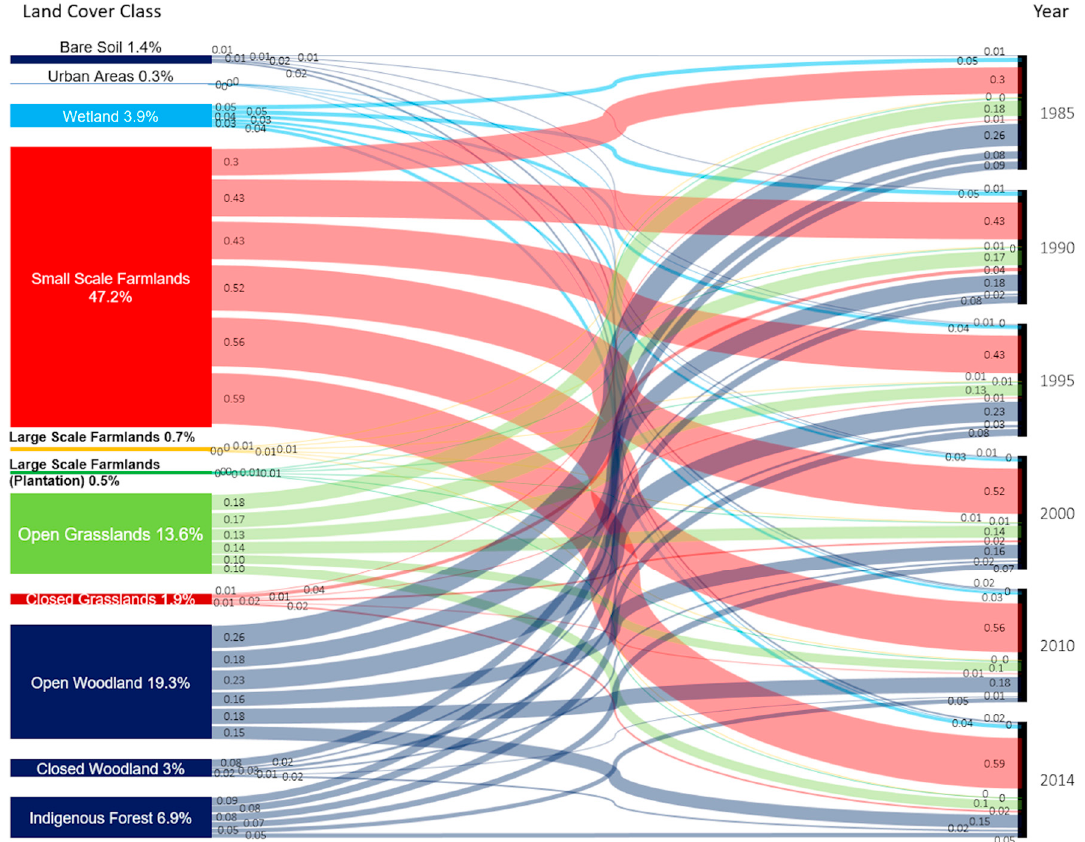
Figure 6. A Sankey diagram showing the mean proportion of area for each class, relative to the total land area for the entire LVB (around 18.7 million hectares), excluding the lake area. The proportion of each class accounted for in each year is illustrated via the line linking the class to the year on the